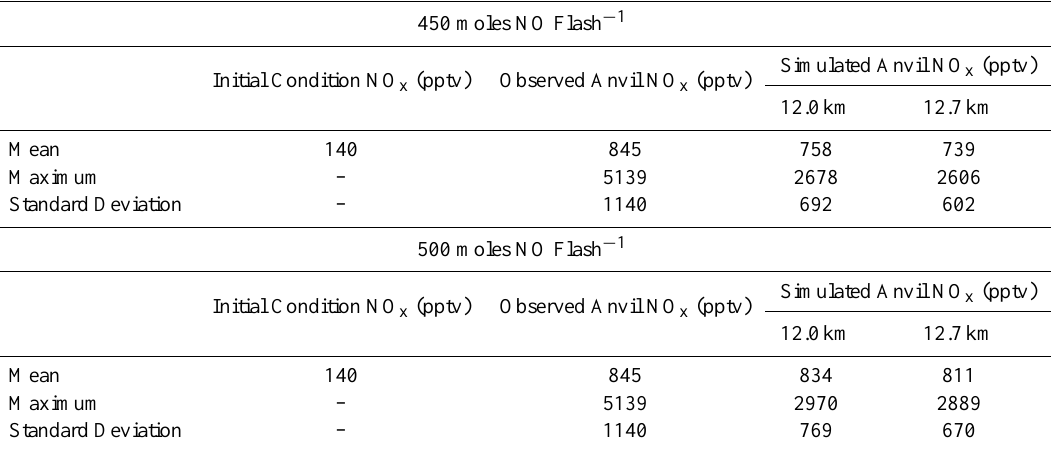
Table 4. Statistics for the Egrett observed NO x mixing ratios for the layer centered at 13.4km compared with the simulated NO x mix- ing ratios for the layers centered at 12.0km and 12.7km. Simulated values are based on a lightning NO production scenario of 450 and 500molesflash − 1 . The layer centered at 13.4km contained 338 11-s Egrett observations and the layers centered at 12.0km (12.7km) con- tained 2236 (1782) simulated